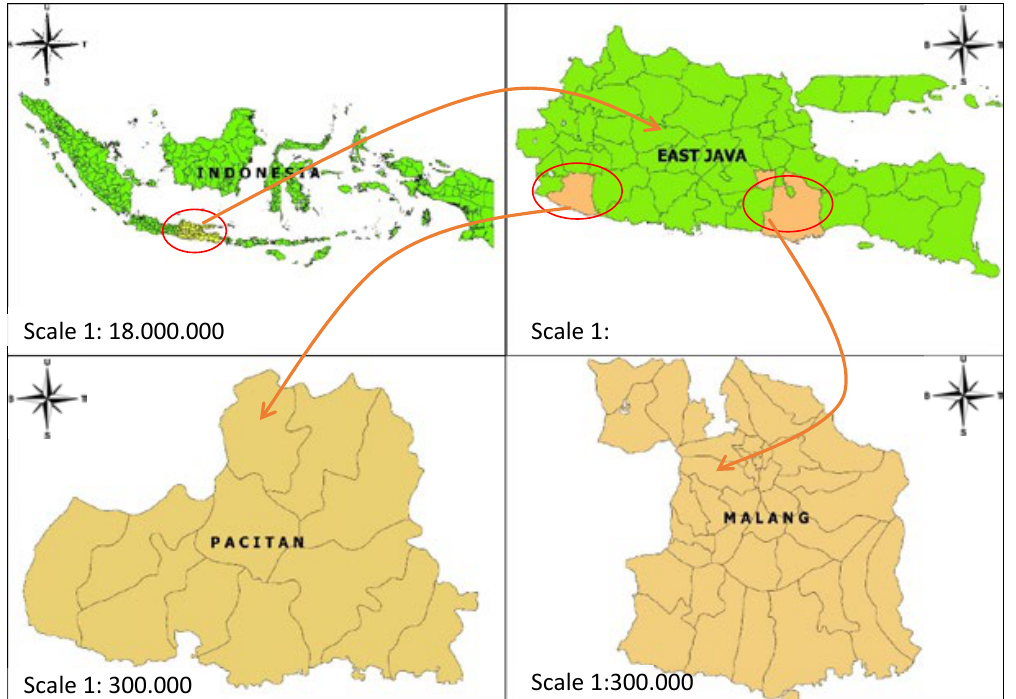
Scale 1: 300.000 Fig. 1(a): Geographic location of the study area at the Siwil Beach and Sempu Island, in Indonesia